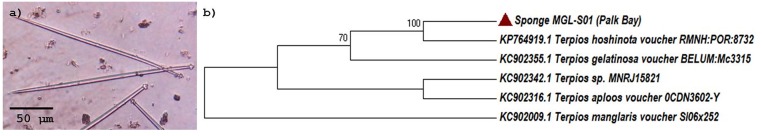
Identification of coral encrusting sponge collected from Palk Bay.a. Spicules of T. hoshinota showing lobed head of tylostyle spicules, b. Molecular phylogenetic analysis of Terpios sp. with related sponge species.